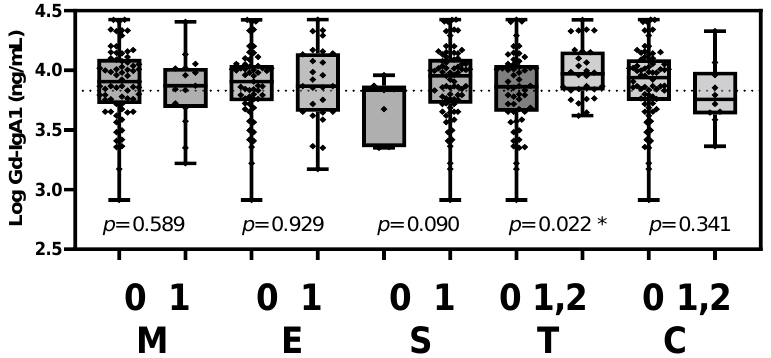
Figure 3. Plasma Gd-IgA1 levels stratified according to the Oxford MEST-C criteria. Plasma Gd- IgA1 level was significantly elevated in patients with tubular atrophy/interstitial fibrosis ( p = 0.022). Gd-IgA1, galactose-deficient IgA1; M, mesangial hypercellularity; E, endocapillary hypercellularity; S, segmental glomerulosclerosis; T, tubular atrophy/interstitial fibrosis; C, cellular or fibrocellular crescents. * p < 0.05.